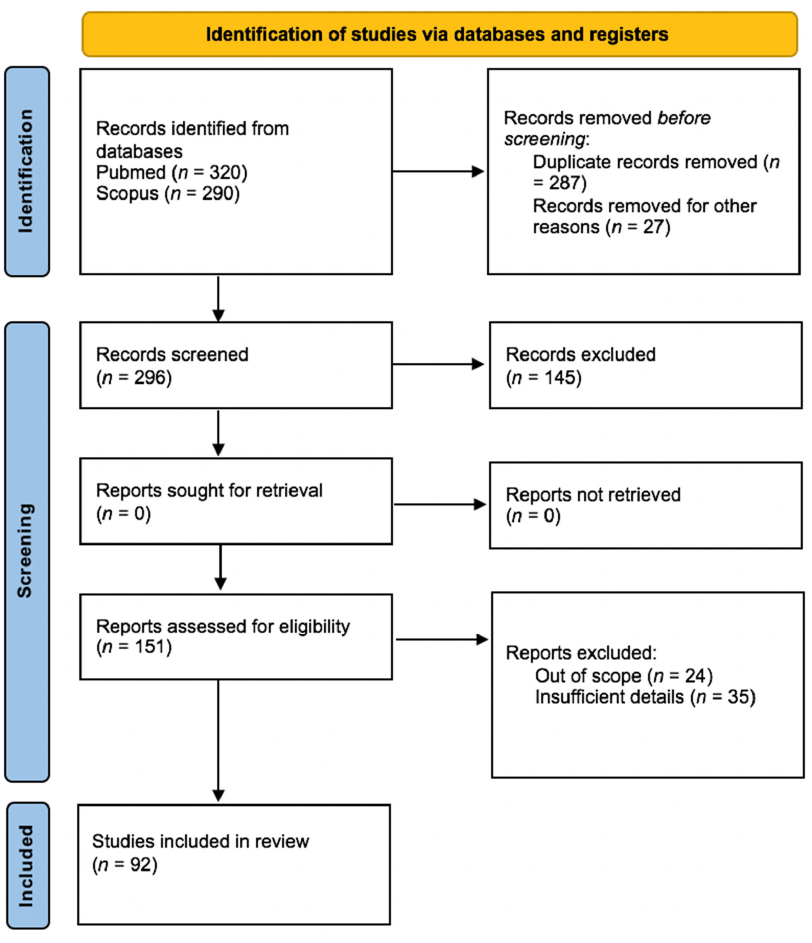
Figure 1. PRISMA 2020 flow diagram. Table 2. Type of contact